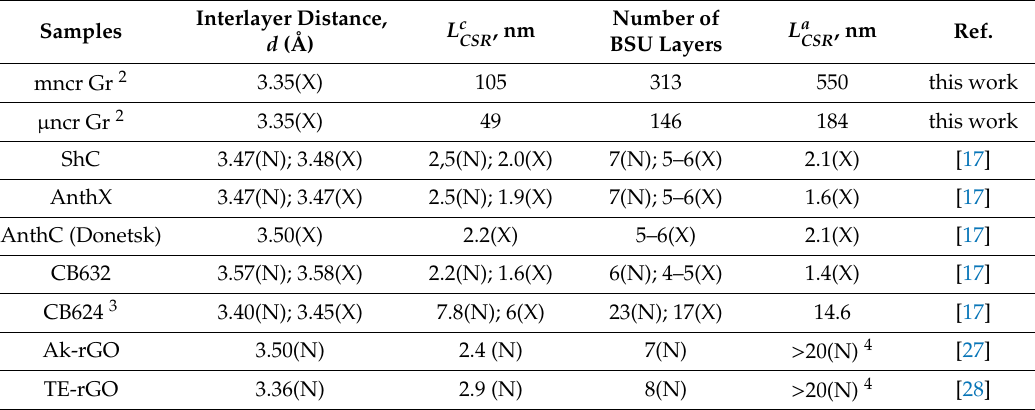
Table 2. Chemical content of amorphous carbons.